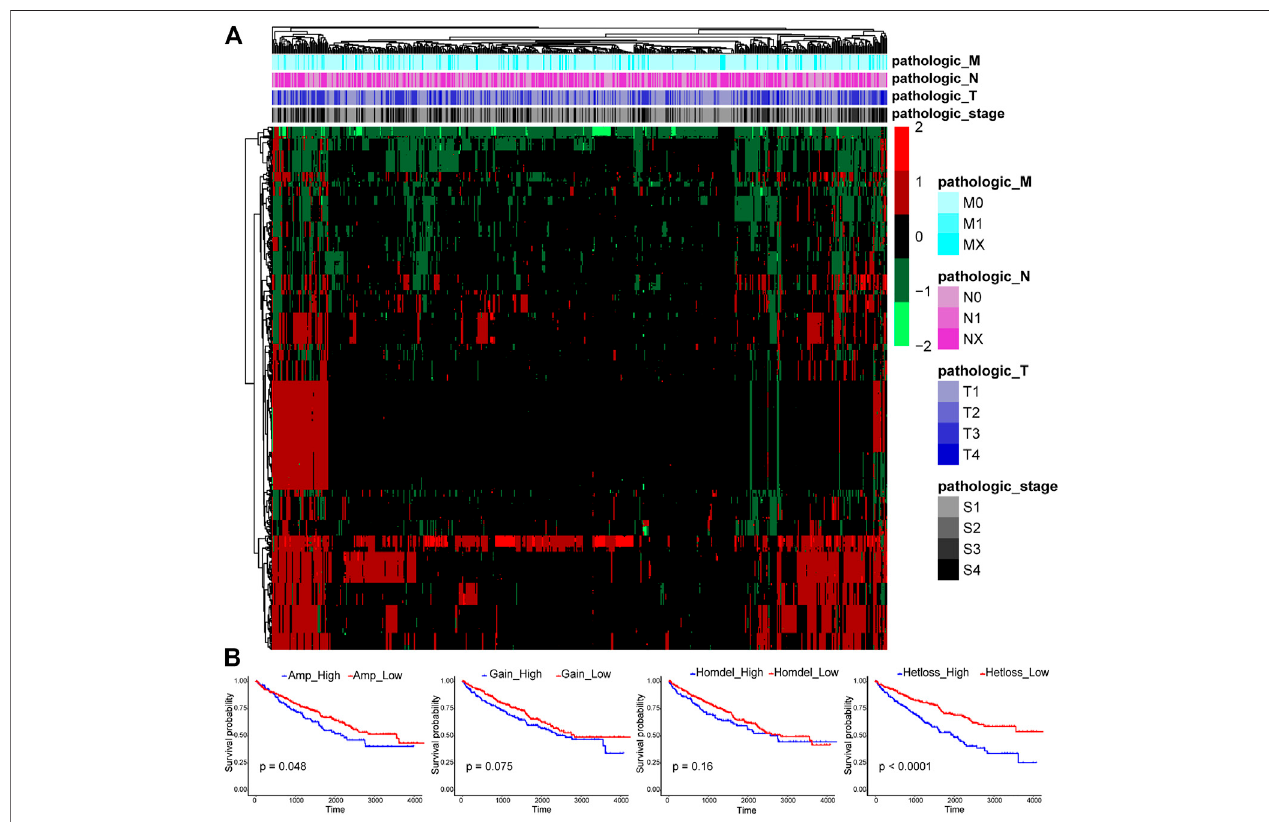
FIGURE1| Expressionpro fi lesofcopynumber alterations(CNAs)oftranscriptionfactors(TFs)andrelatingoverallsurvivalanalysisinclearcellrenalcellcarcinoma (ccRCC). (A) The CNA heatmap of524ccRCC tissue samplesin theTCGA KIRC cohort shows mostTFs arediploid,some TFsare heterozygous deletion (Hetloss)and low-levelampli fi cation(Gain),andaminorityofTFsarehomozygousdeletion(Homdel)andhigh-levelampli fi cation(Amp). (B) PatientsinAmp-highgroup( p (cid:2) 0.048)and Hetloss-high group ( p < 0.0001) have worse overall survival (OS), but no statistical difference was seen in Gain ( p (cid:2) 0.075) and Homdel ( p (cid:2) 0.16)